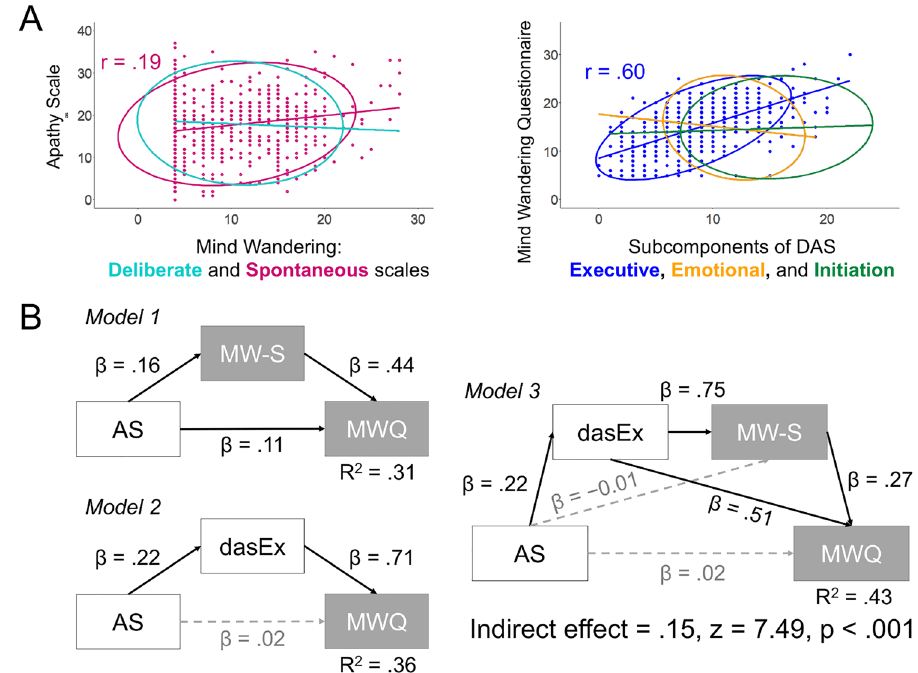
Figure 3. Replication of Study 1. Scatter Plots of the Correlations Between Mind Wandering and Motivational Indices ( A ) and the Results of the Mediation Analyses ( B ). Note As in Fig. 1, data for non-significant correlations after multiple corrections are only shown within the 95% elliptical confidence region of the multivariate t-distribution in panel A . In panel B , the models were identical as those in Study 1. The solid black line indicates the significant path, while the dashed grey line denotes the non-significant path. AS = apathy scale; MW-S = spontaneous MW scale, MWQ = mind wandering questionnaire; DAS = dimensional apathy scale and dasEx = executive subcomponent of DAS. Higher scores on the apathy scale and DAS indicate increased amotivation.